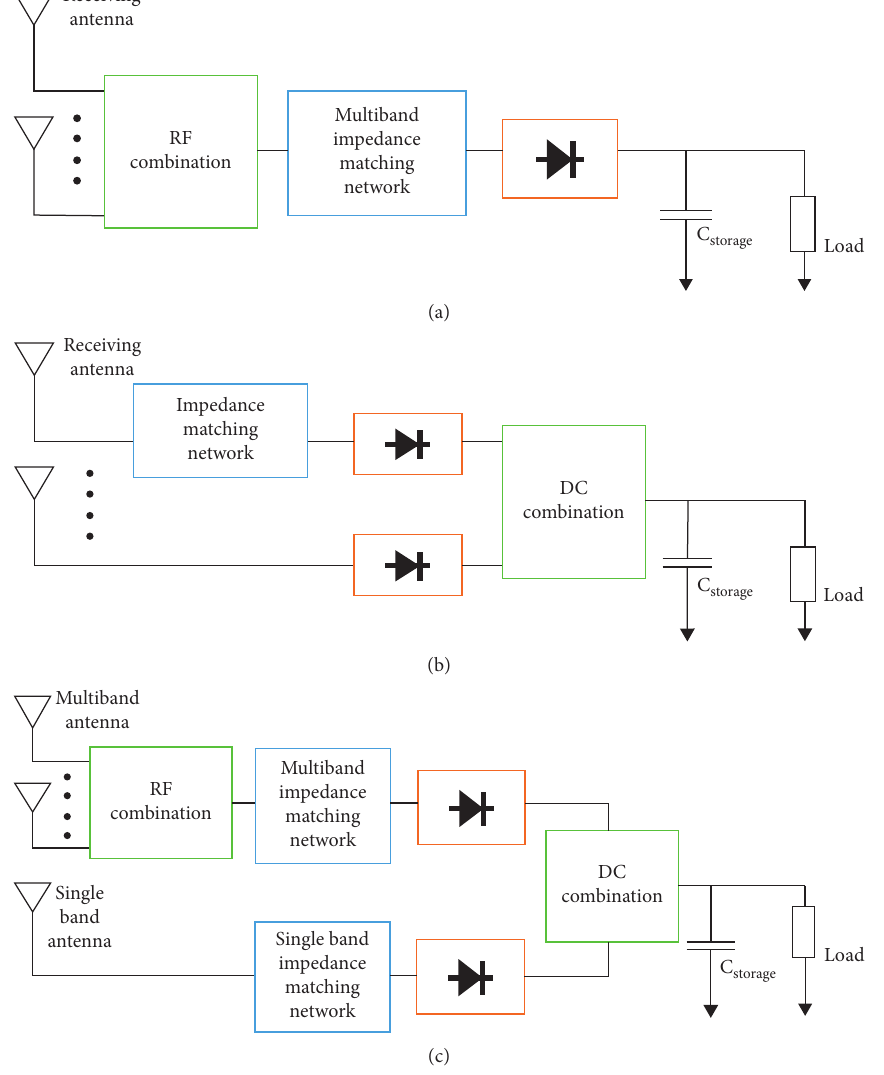
Figure 1: Rectenna array topologies. (a) Multiple antennas with RF combination and single multiband rectifier. (b) Multiple antennas with separate rectifiers and DC combination. (c) Proposed hybrid topology.